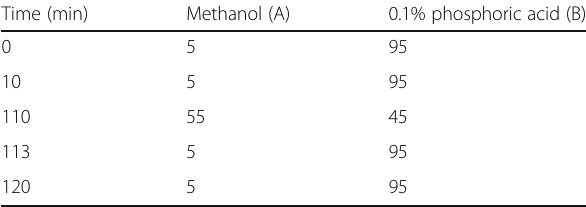
Table 2 The mobile phases of HPLC